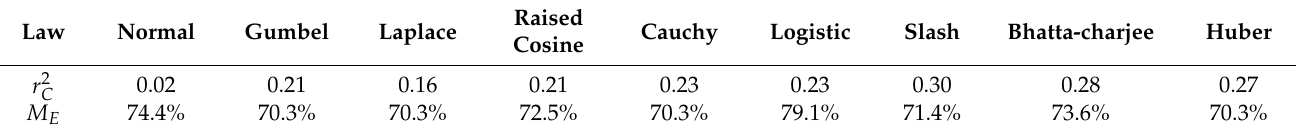
Table 9. Error margin ( M E ), and Pearson’s correlation coefficients ( r 2 C PICP calculated for each class of 20-cm groundwater levels having a negative